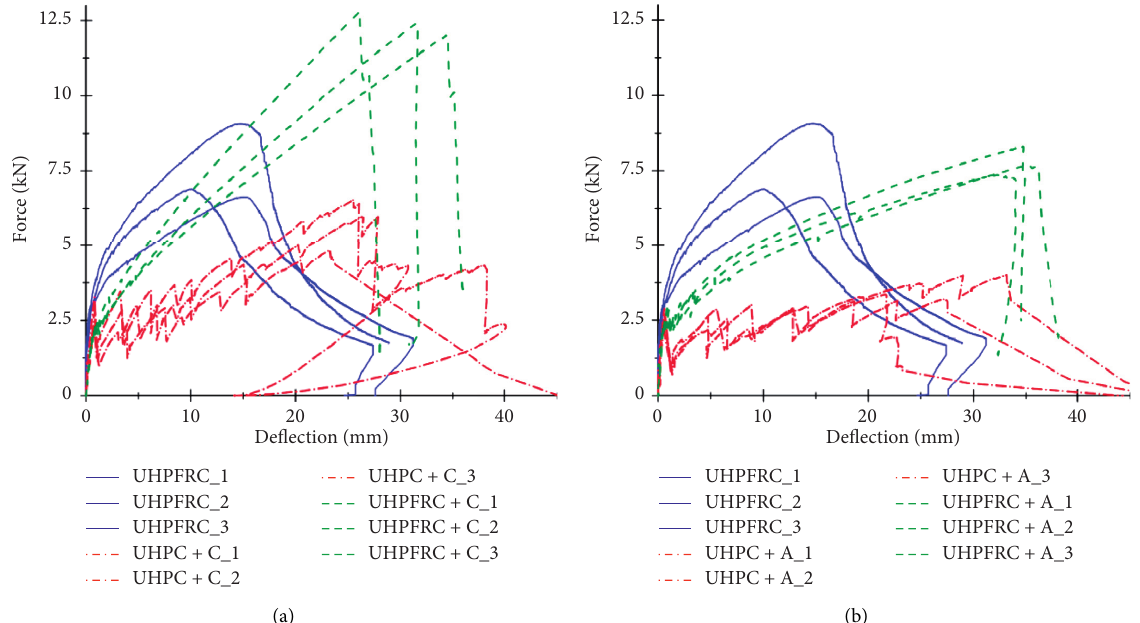
Figure 2: Comparison of load-deflection curves by using UHPC and UHPFRC with and without (a) carbon textile and (b) glass